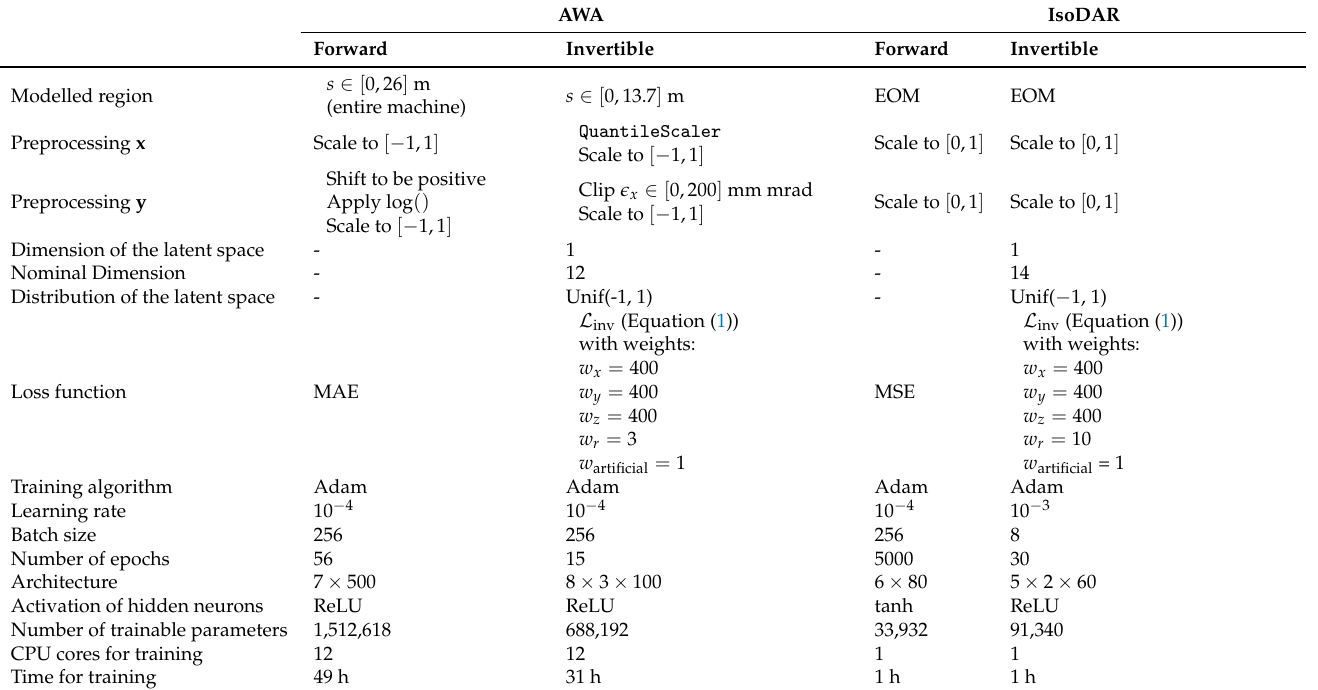
Table A7. Parameters and properties of our surrogate models. EOM means end of the